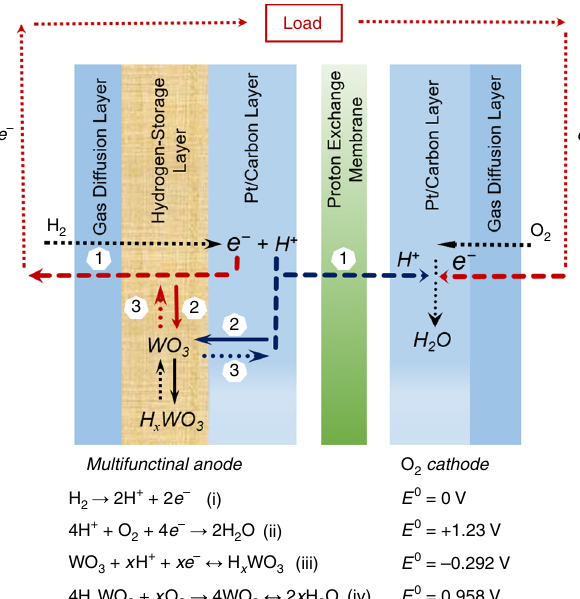
Fig. 1 Design of a hybrid proton-exchange membrane fuel cell. Schematic of a membrane-electrode assembly (MEA) for the hybrid PEMFC with a WO 3 -based multifunctional anode. The cell functions through the reactions (i) and (ii), where electrons and protons go through the pathway 1. The WO 3 layer serves as a rapid-response hydrogen reservoir storing and releasing electrons and protons based on the reaction (iii) through pathways 2 and 3, respectively. The WO 3 layer also serves as a scavenger for oxygen invaded to the anodes through the reaction (iv) and a regulator for the hydrogen-disassociation reaction